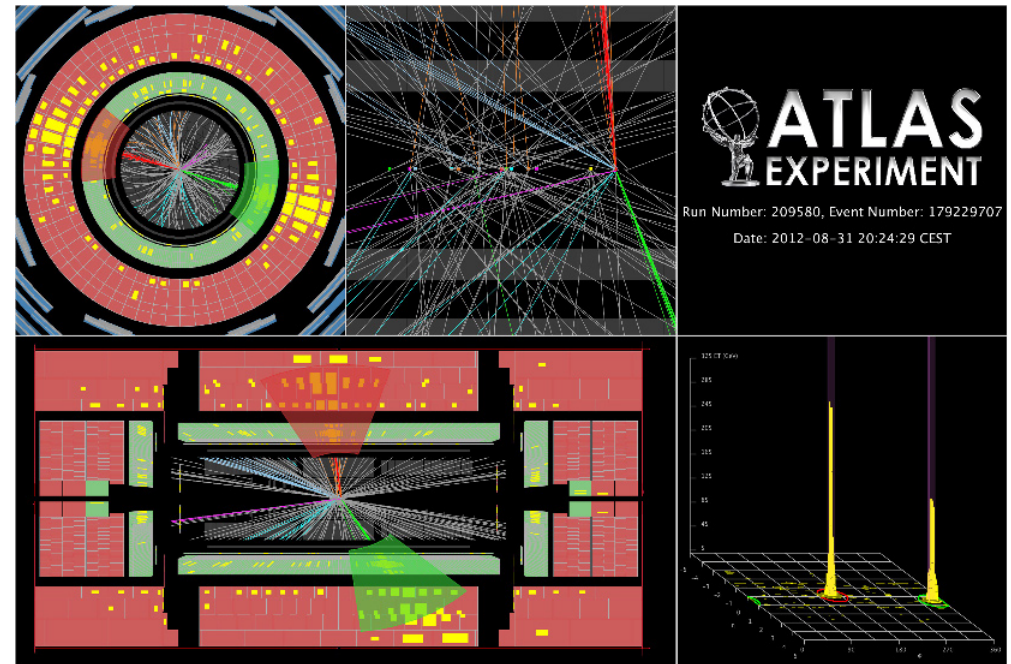
Figure 5. Event display of the highest m jj event observed. The two leading jets have an invariant mass of 4.69 TeV. The leading jet has a p T of 2.29 TeV while the subleading has a p T of 2.19 TeV